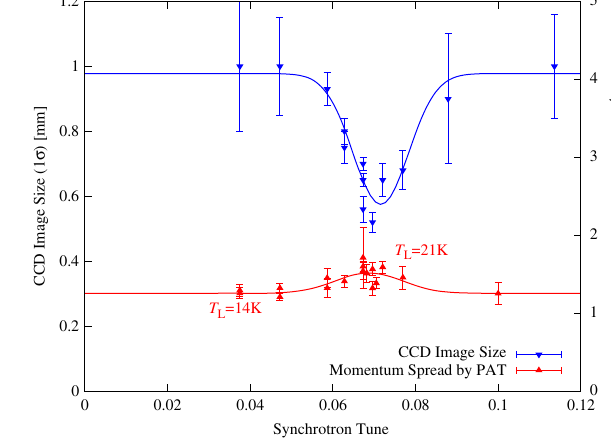
FIG. 10. Time evolution of the horizontal beam size at three different synchrotron tunes, i.e. (cid:1) s ¼ 0 : 038 , 0.060, and 0.068. When the linear coupling resonance is excited ( (cid:1) s ¼ 0 : 068 ), the CCD image size in the horizontal direction continuously de- creases from (cid:4) 1 mm ( 1 (cid:2) ) to 0.55 mm ( 1 (cid:2) ), which means that the horizontal beam temperature is reduced to (cid:4) 200 K by indirect laser